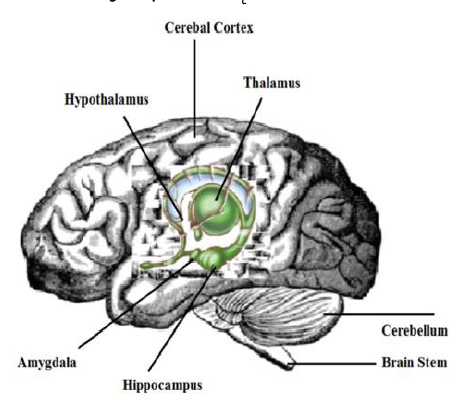
Figure 4. The limbic system of the brain [28].